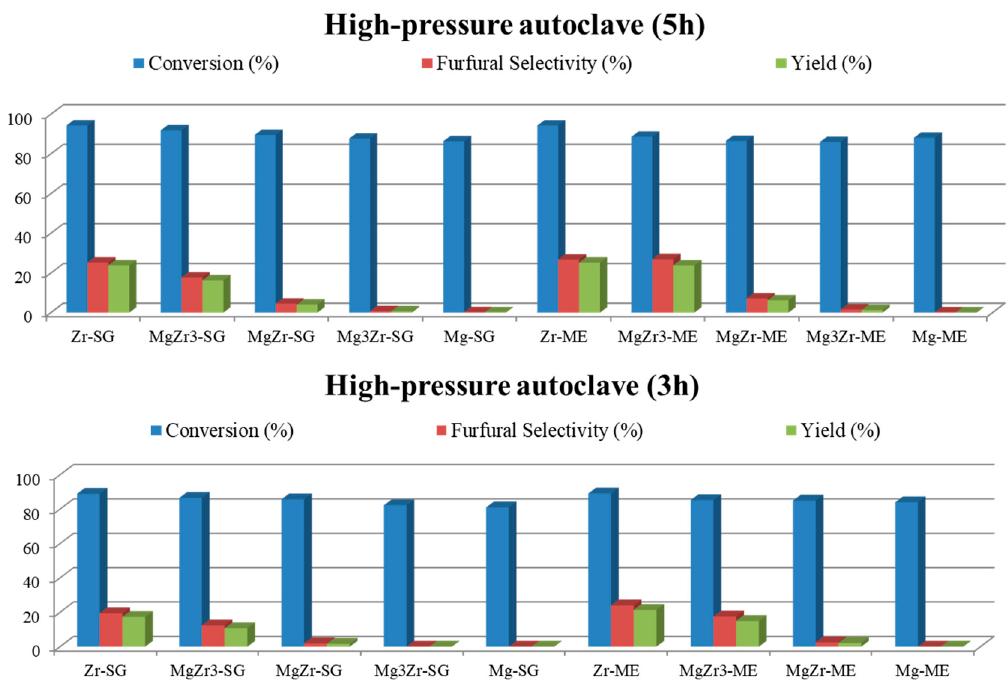
Figure 9. Catalytic activity in xylose dehydration in a high-pressure autoclave in a toluene/water biphasic media at 3 and 5 h of reaction, and 150 °C.